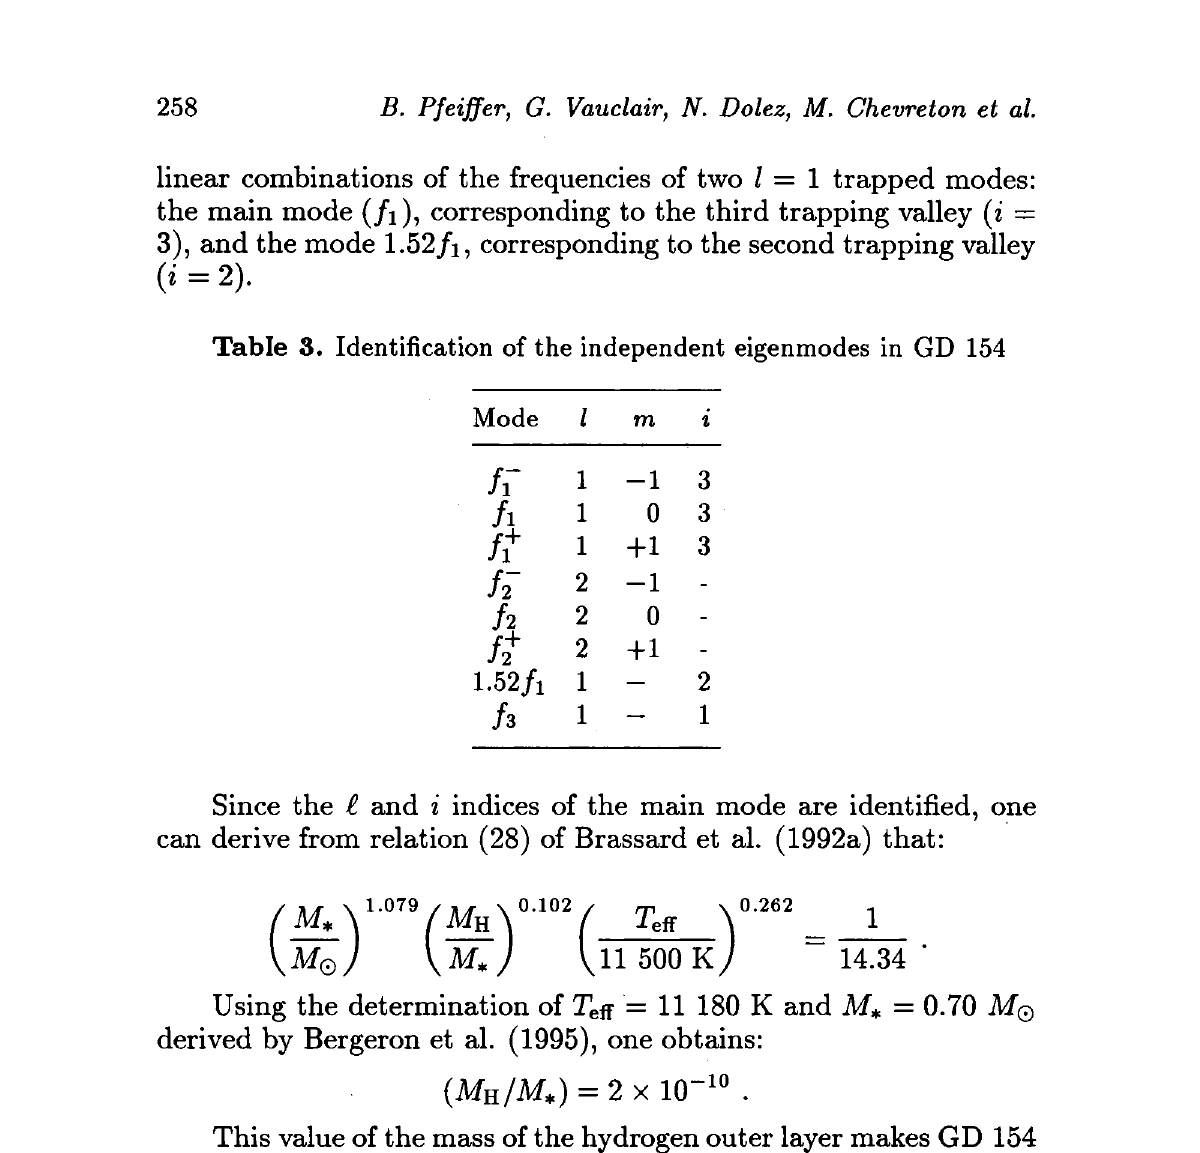
Table 3. Identification of the independent eigenmodes in GD